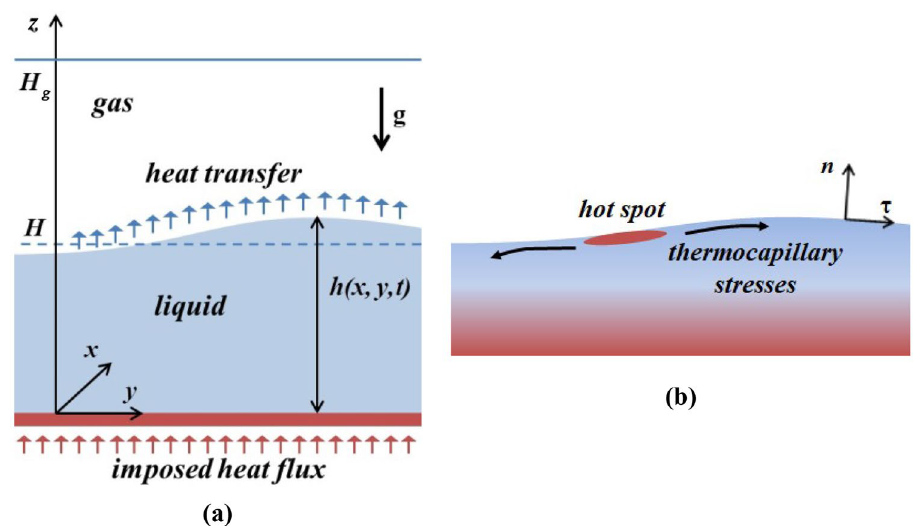
Fig. 1 a A schematic of thin liquid film atop a solid substrate. The dashed line represents the locations of the unperturbed interface. The deformable interface is located at z = h ( x,y,t ). b A schematic of thermocapillary